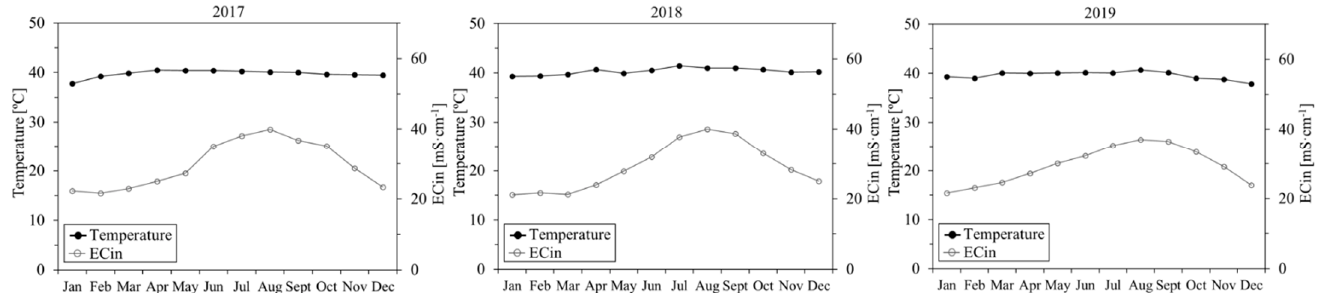
Figure 4. Annual evolution of feedwater temperature and electric conductivity (ECin) in 2017, 2018 and 2019.